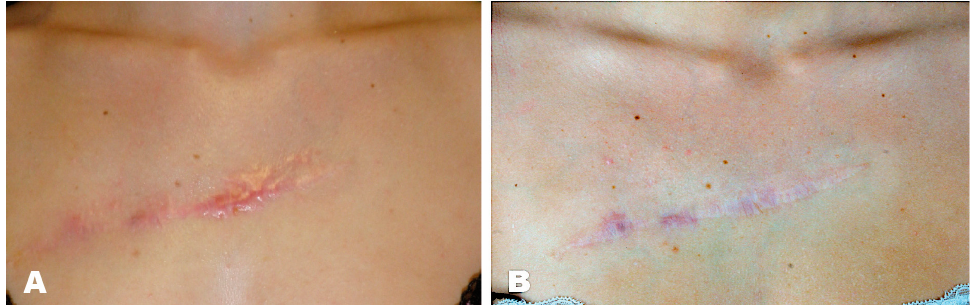
Figure 1. ( A ) Preoperative hypertrophic scar, ( B ) 3 months postoperative outcome after triamcinolone treatment.